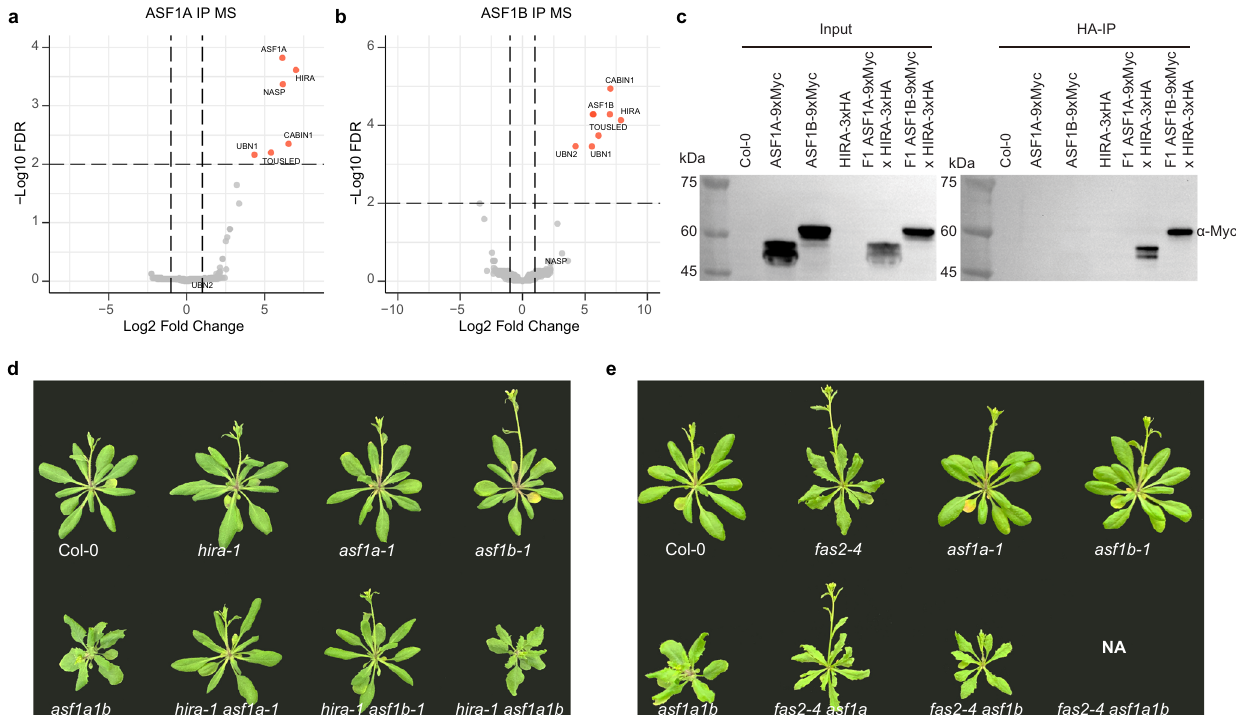
Fig. 2 | Genetic relationships between H3Histone chaperone mutants. Volcano plots showing proteins interact with ASF1A ( a ) and ASF1B ( b ) identi fi ed by IP-MS. Thedistributionofidenti fi edproteinsaccordingtotheLog2foldchangeofaverage spectral counts and − Log10 FDR values. Proteins with FDR<0.01 are in red. c Co- immunoprecipitation assay ofASF1A,ASF1B,and HIRA. Labelsto the right indicate